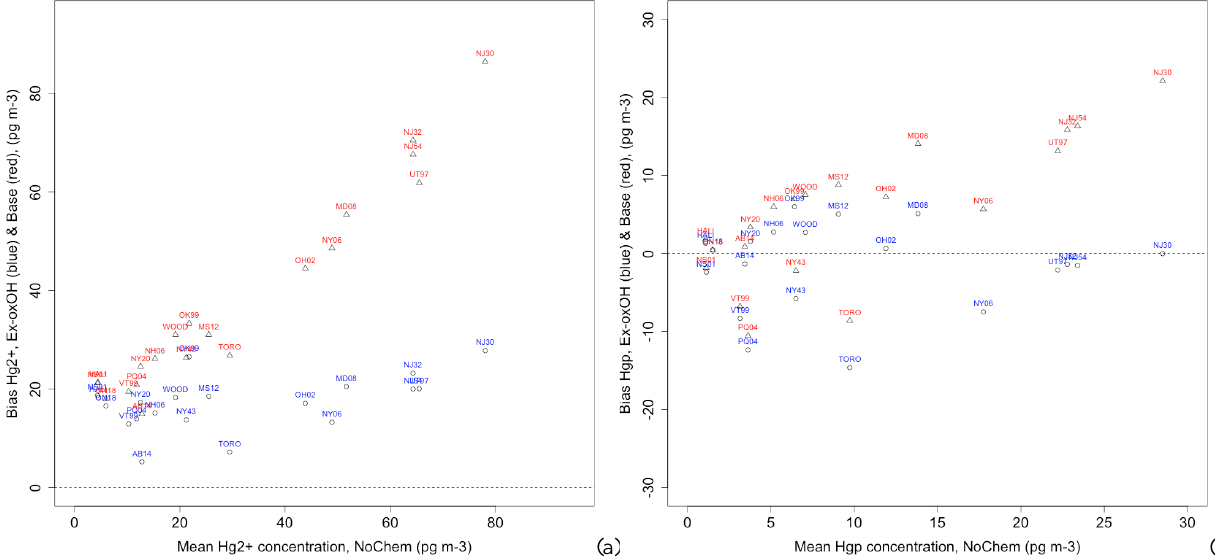
Fig. 5. Model plot of base and Ex-OH bias for (a) Hg 2 + and (b) Hg p at locations with distance from source. Distribution of Hg 2 + in the NoChem experiment (plotted on the x-axis) is determined by the dispersion of these species from the emission sources only. Higher concentrations on the x-axis, therefore, represent proximity to the emission sources. On the left are remote stations, on the right stations close to